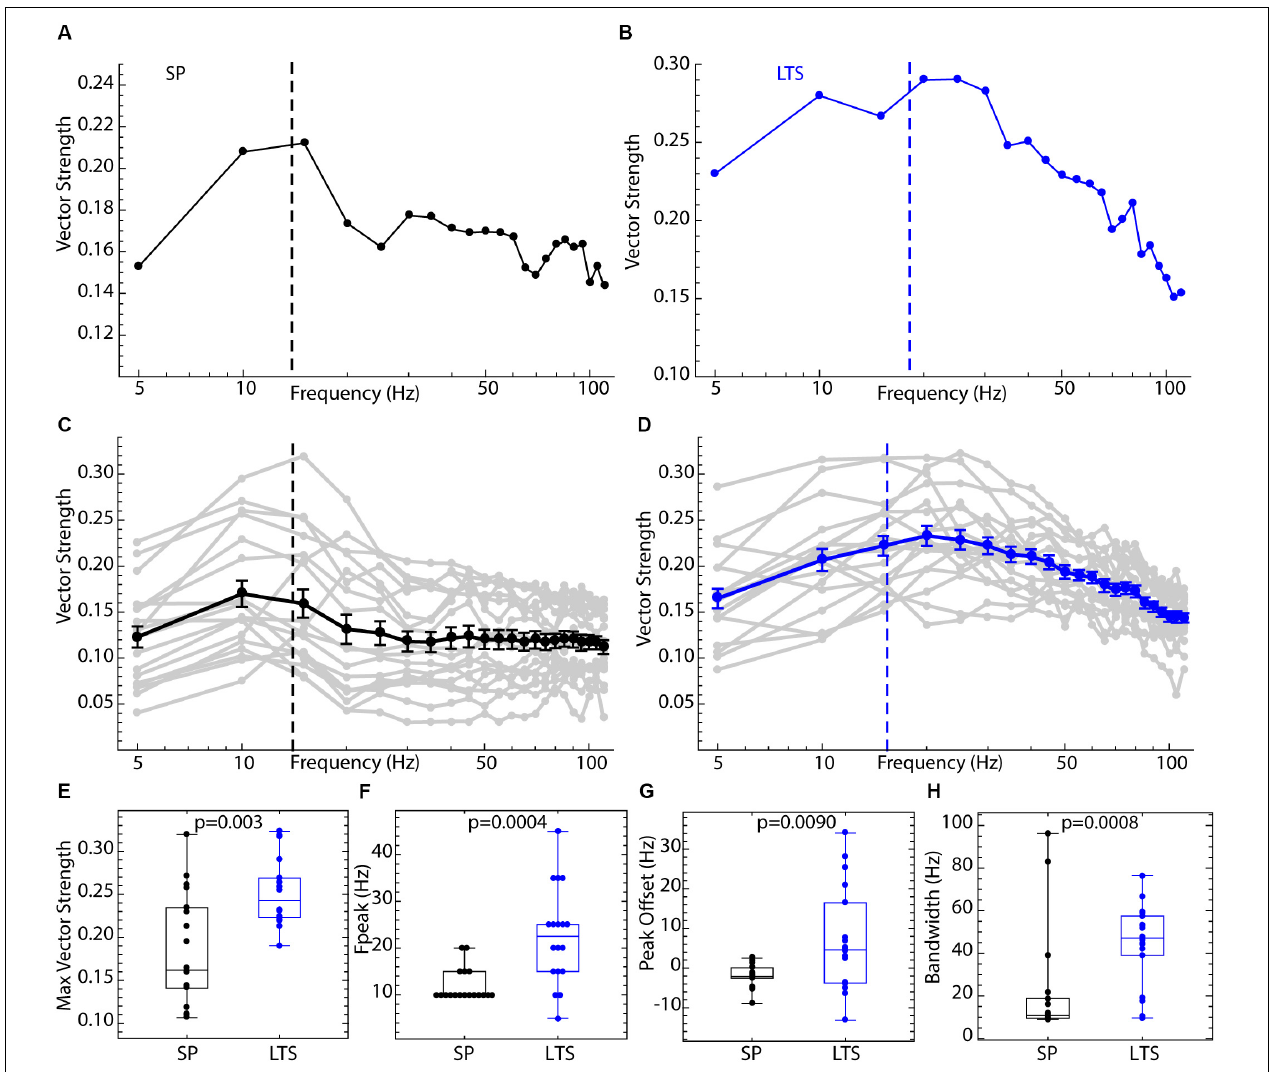
FIGURE 3 | Comparison of spiking resonance in SP neurons and LTS interneurons. (A) An example spiking resonance spectrum from an SP neuron. The cell’s firing rate is indicated by the dotted line. (B) An example LTS interneuron shown the same way. (C) Superimposed spiking resonance spectra (gray) and the average spiking resonance (black) for 18 SP neurons. (D) Superimposed individual spectra (gray) and average spectrum (blue) for 18 LTS interneurons. Error bars are standard errors of the mean at each frequency. The dotted lines indicate the average firing rates for the two groups of cells. (E) LTS interneurons showed a higher vector strength overall than SP neurons. (F) The frequency at the peak resonance was higher in LTS interneurons. (G) The difference between the firing rate and peak frequency for each cell was greater in LTS interneurons. (H) The bandwidth of resonance (measured as shown in Figure 2 ) was greater in LTS